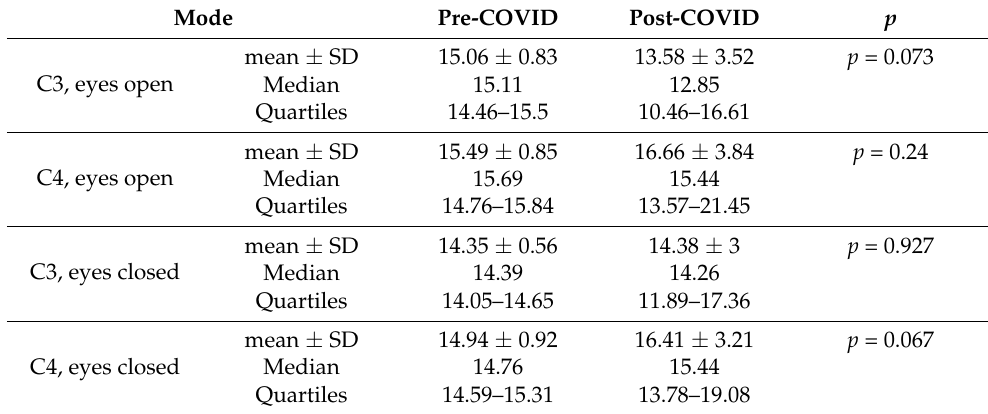
Table 1. The results of the Delta waves examination (waves from C3, C4 channels). The values are expressing the wave amplitude (in µ V), with demonstration of main distribution parameters (including median and quartiles); p -values are referring to the results of the Wilcoxon test in a given set of records.